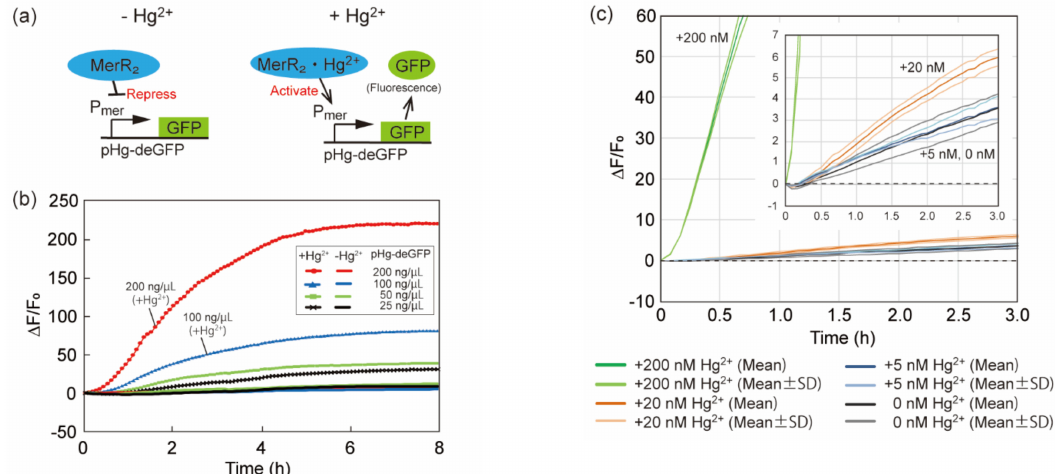
Figure 5. Characterization of mercury sensing DNA (pHg-deGFP). ( a ) Schematic diagram of mercury sensing using the mercury sensing DNA. ( b ) Time-course of the fluorescent intensities of the CFPS solution with various pHg-deGFP concentrations. +Hg 2+ and − Hg 2+ represent the sample with/without 200 nM of Hg 2+ respectively. ( c ) Time-course of the average fluorescent intensities of the CFPS solution with various Hg 2+ concentrations. The CFPS solution contained 200 ng/ µ L of pHg-deGFP. The inset shows the magnified graph around ∆ F/F 0 = 0. Curves with the dark colors represent average (Mean). Curves with the light colors represent average ± standard deviation ( n = 3) (Mean ± SD). The time interval between each data acquisition in ( b , c ) was 5